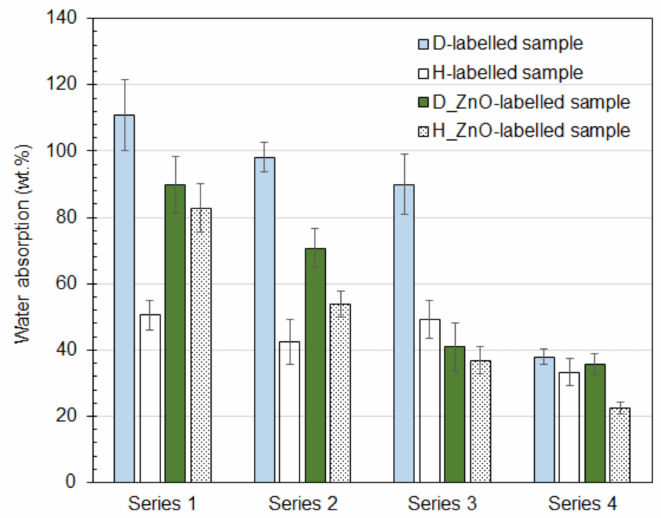
Figure 7. Water absorption into coatings based on latexes, differing in the covalent crosslinking strategy, surfactant type and addition of nanostructured ZnO. The water absorption was measured after 30-day immersion in distilled water at RT.